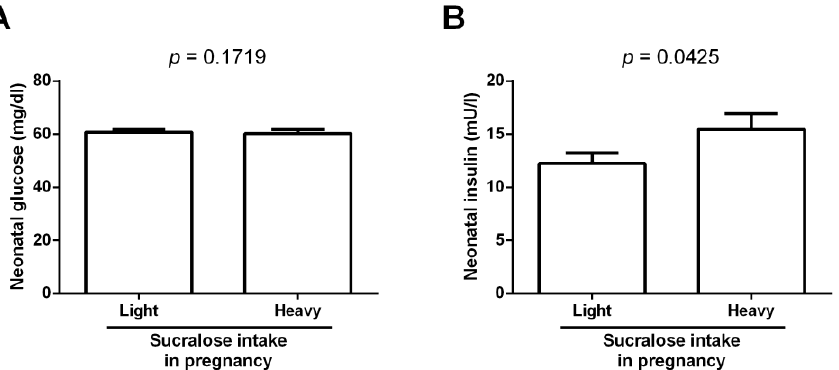
Figure 1. Glucose and insulin levels in neonates lightly or heavily exposed to sucralose during pregnancy. ( A ) Cord blood glucose levels in newborns lightly or heavily exposed to sucralose. ( B ) Cord blood insulin levels in neonates lightly or heavily exposed to sucralose. We measured glucose and insulin in umbilical cord blood from all infants. We expressed data as mean ± standard deviation. We compared data by the unpaired Student’s t -test, considering differences significant when p <